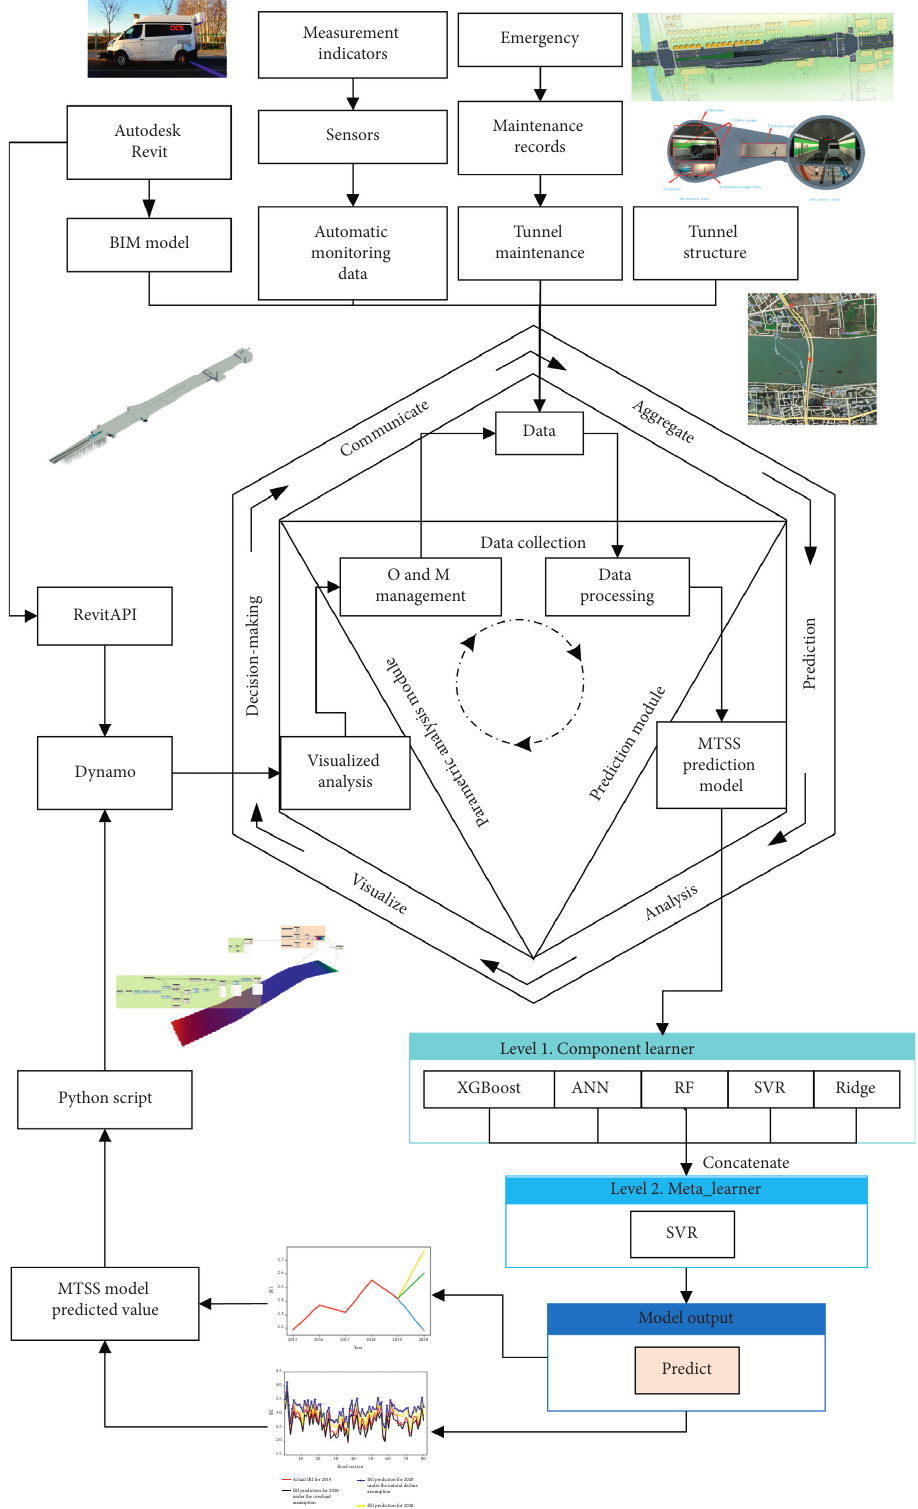
Figure 2: A digital twin for pavement performance